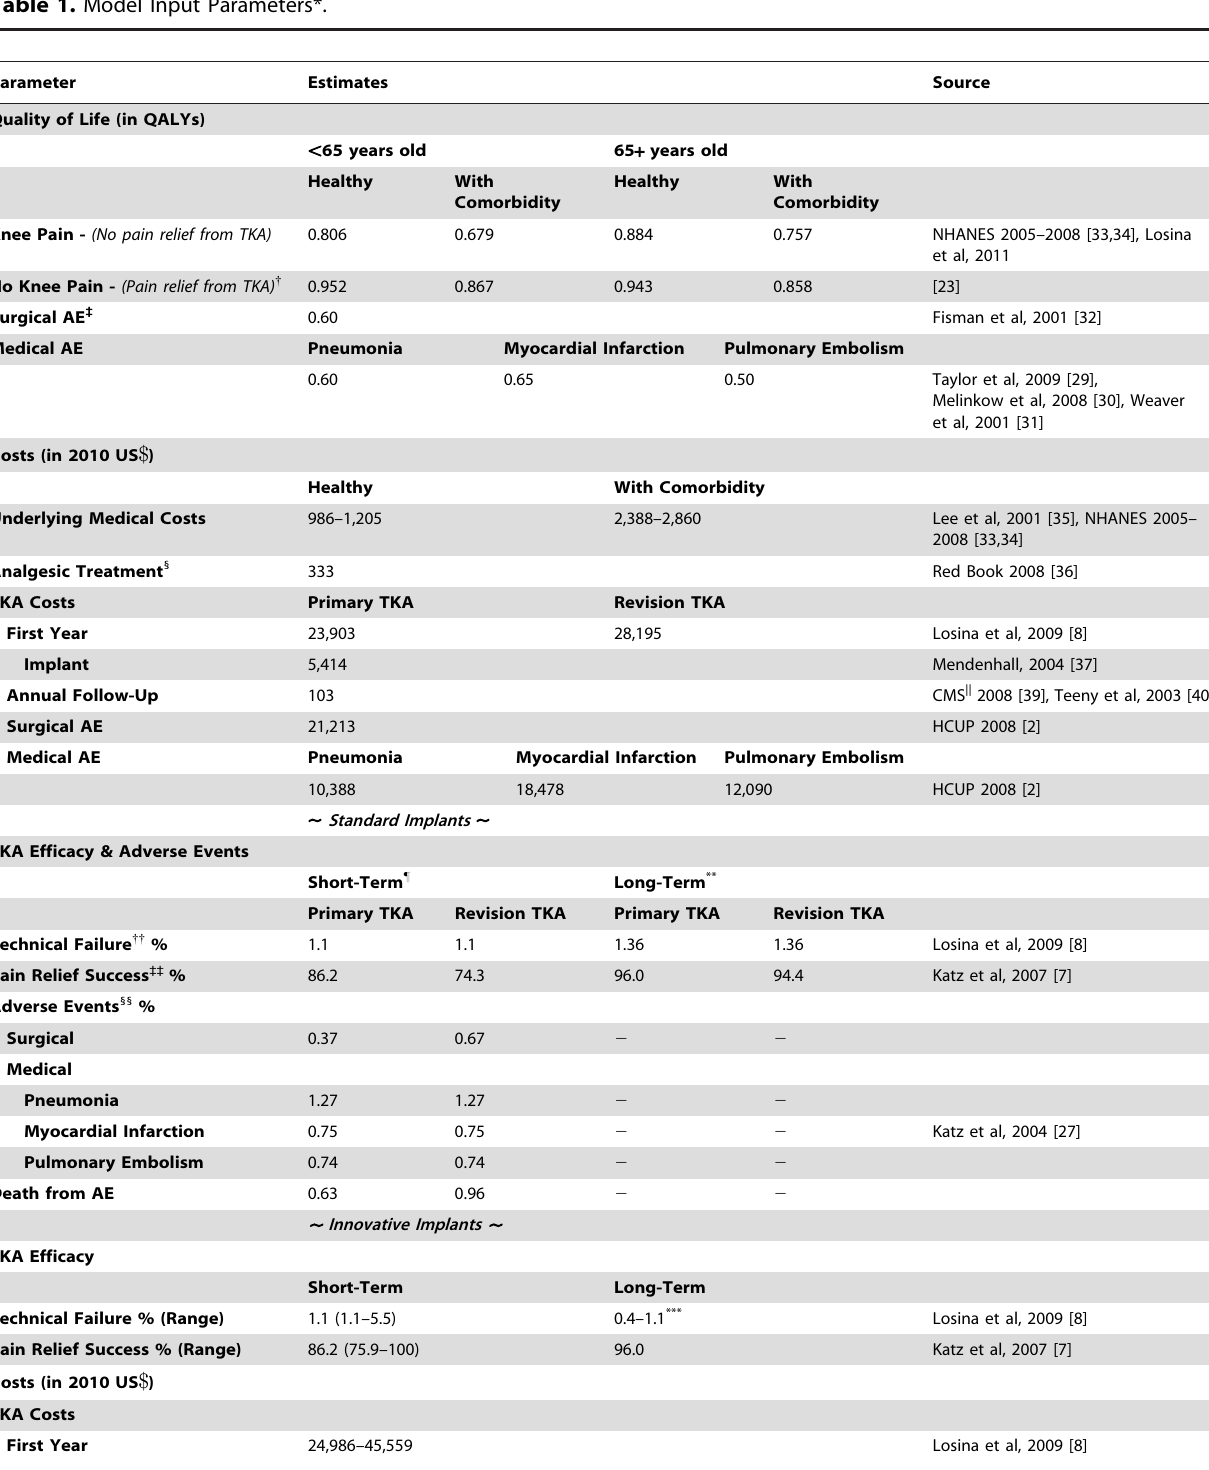
Table 1. Model Input